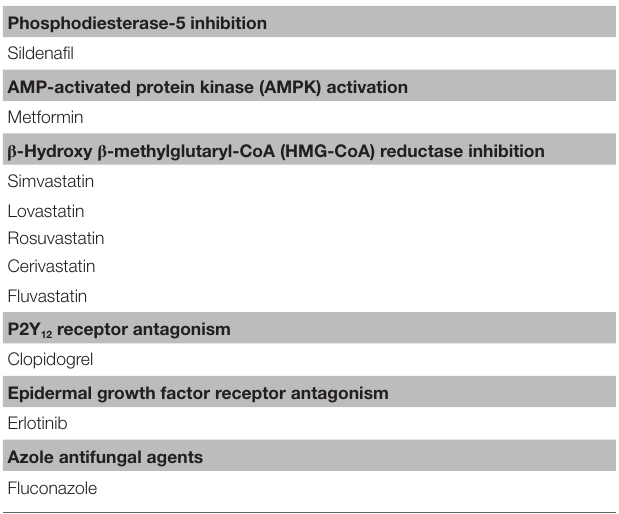
TABLE 2 | Experimental antidiuretic agents without causing